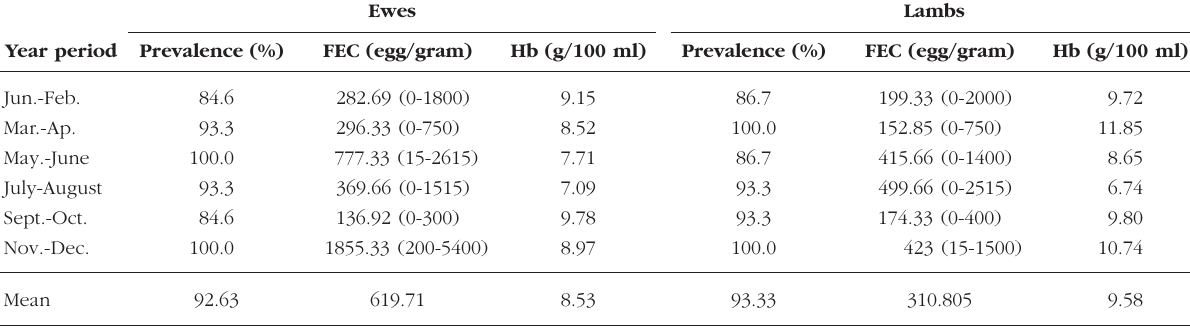
Table II. – Variation of prevalence, coproscopy and haemoglobnemia in the flock at each grazing period during 2004.